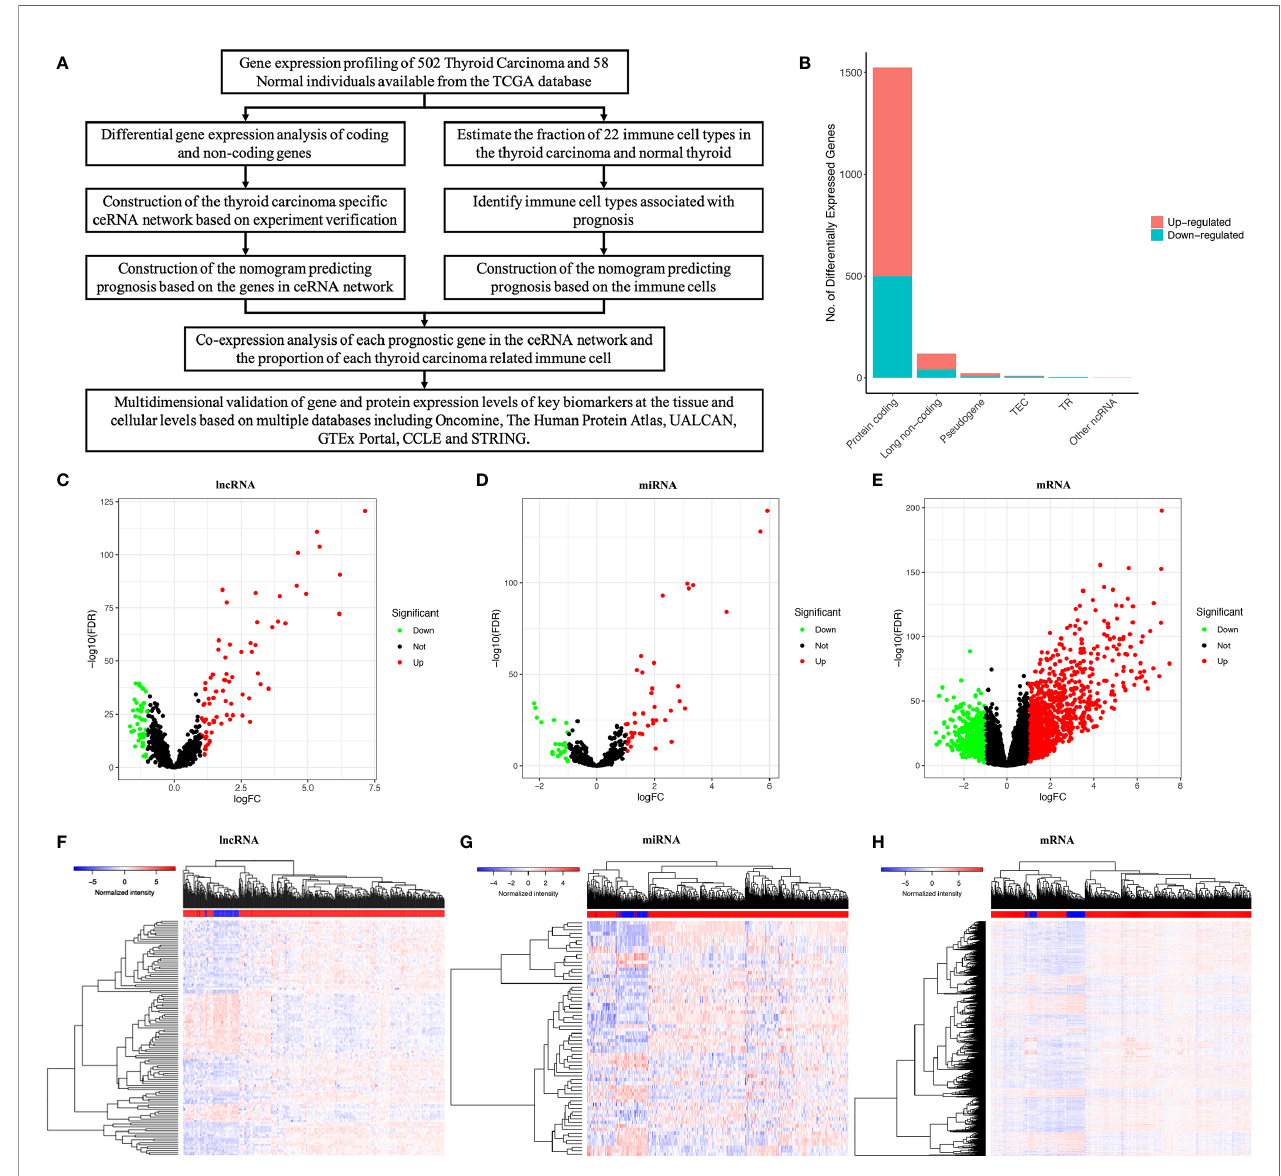
FIGURE 1 | The whole analytical process of this study (A) ; total of lncRNAs, mRNAs and miRNAs from TCGA (The Cancer Genome Atlas) database (B) ; differentially expressed lncRNAs; (C, F) ; differentially expressed miRNAs (D, G) ; differentially expressed mRNAs (E, H)